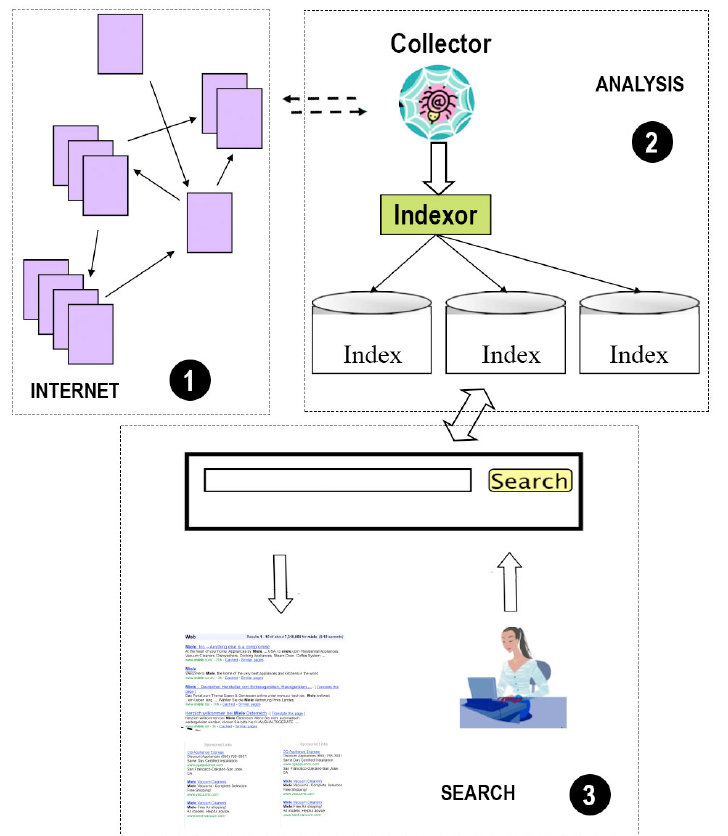
Figure 1 . How a search engine works